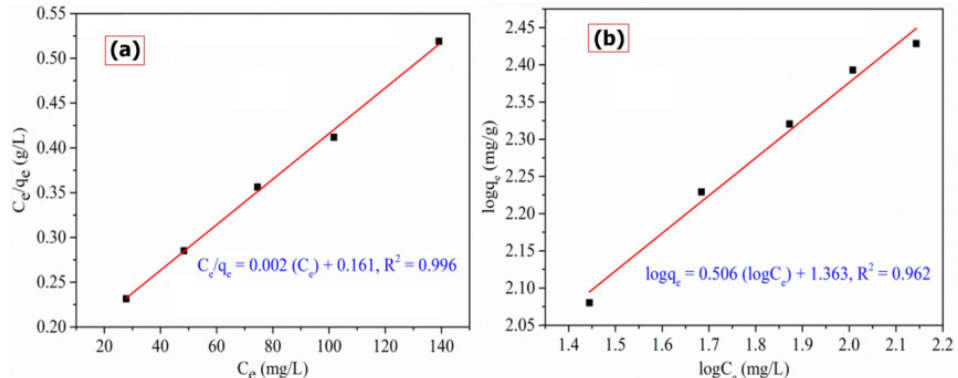
Figure 7. Adsorption isotherm parameters of ( a ) Langmuir, and ( b ) Freundlich model for the removal of RO16 by Cu(I)-PANI composite (initial concentration, pH, dosage, contact time, and volume of solution are 100 mg/L, 4, 0.06 g/L, 100 min, and 100 mL, respectively).